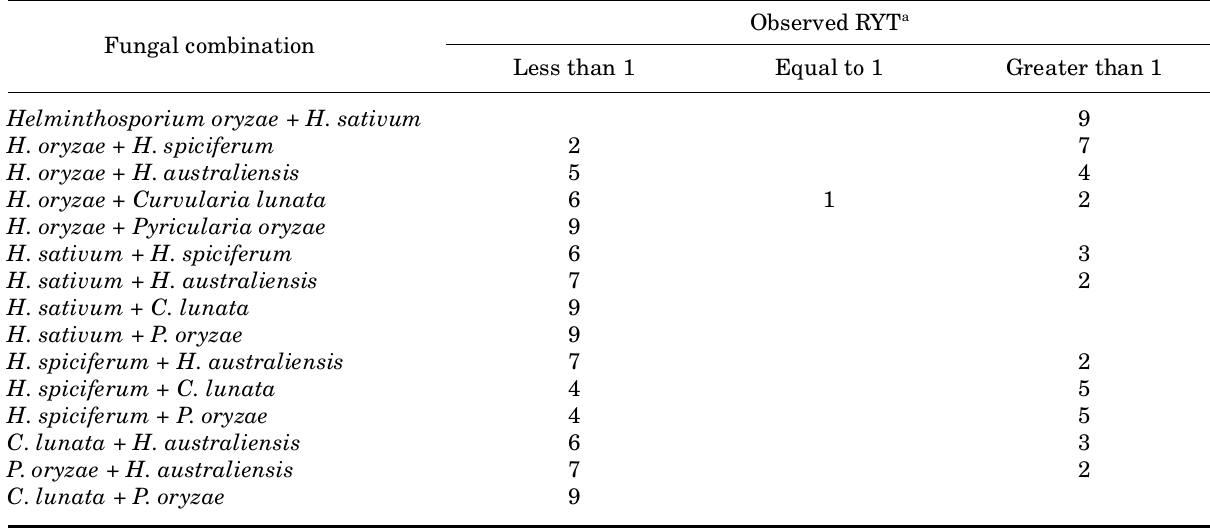
Table 2. Artificial inoculation with various combinations of pathogenic fungi on rice comparing observed relative yield total (RYT) with expected RYT (i.e.